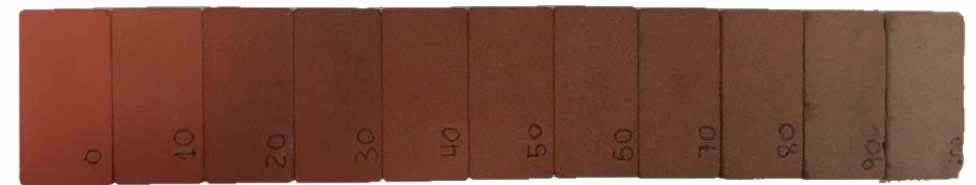
Figure 6. Image of the samples of the different families of ceramics conformed from clay and mining waste. From left to right, 0M10C, 1M9C, 2M8C, 3M7C, 4M6C, 5M5C, 6M4C, 7M3C, 8M2C, 9M1C and 10M0C.